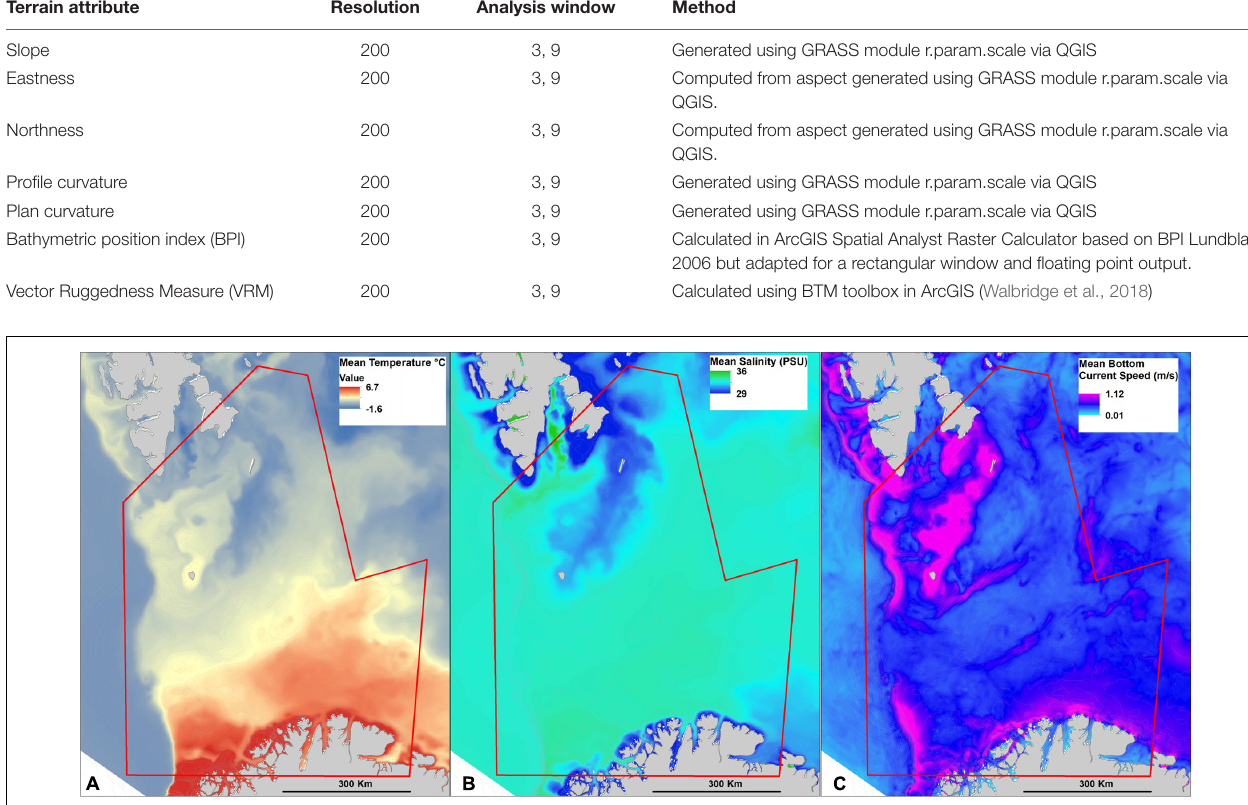
TABLE 1 | Summary of terrain attributes generated from bathymetry data. Terrain